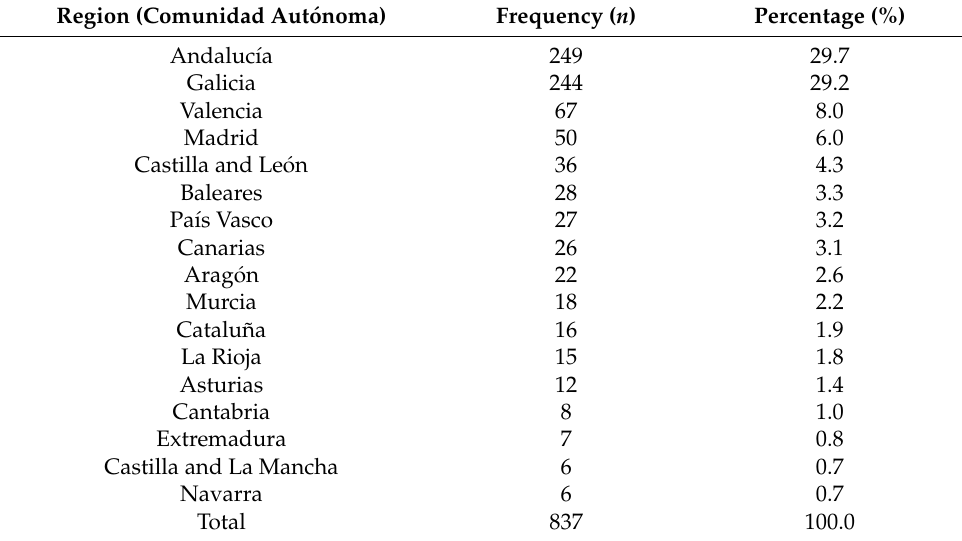
Table 1. Distribution of the sample according to the region in Spain. Region (Comunidad Aut ó